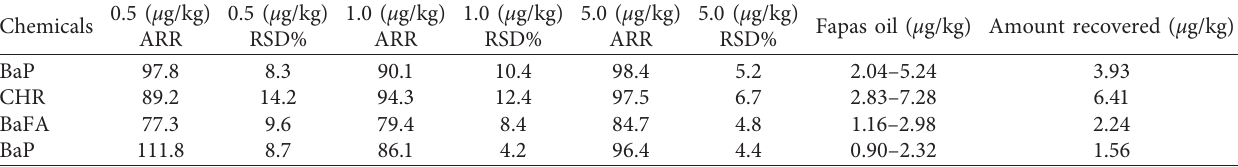
Table 3: Recovery rate of PAH4 in the spiked infant formula